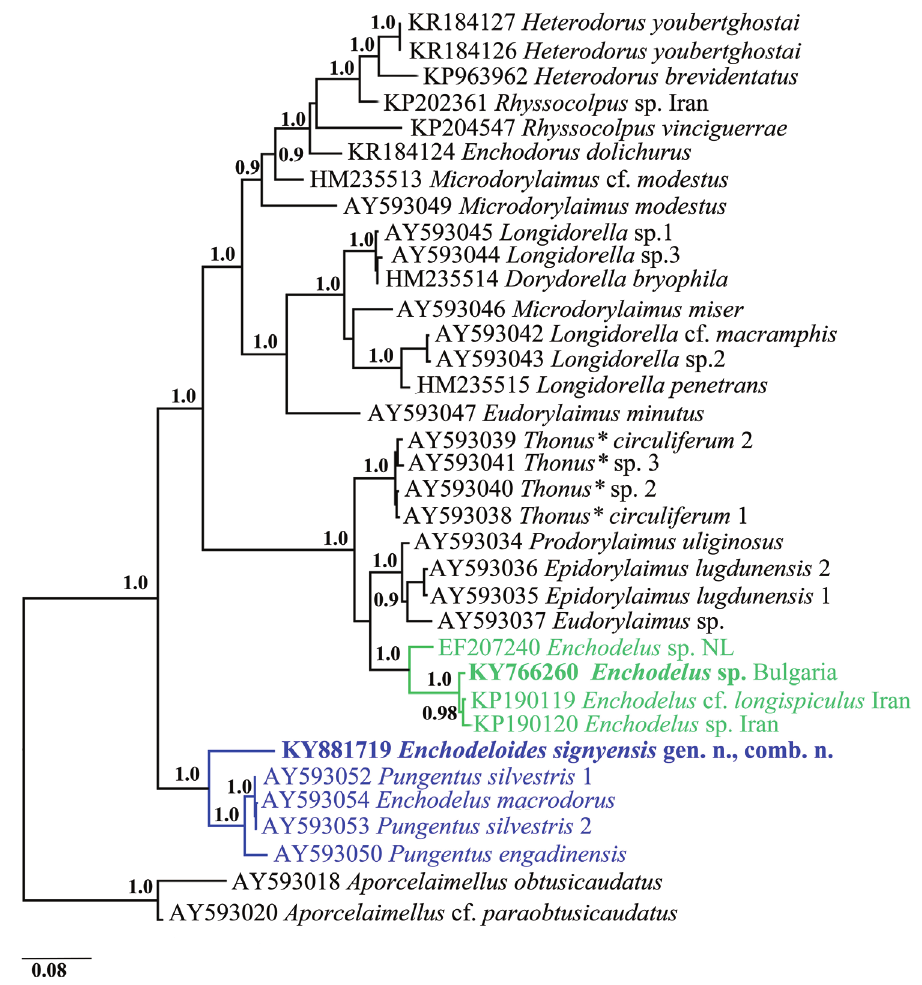
Figure 9. Phylogenetic relationships of Enchodeloides signyensis (Loof, 1975), gen. n., comb. n. (= En- chodelus signyensis Loof, 1975) based on 28S rDNA D2-D3 inferred from a Bayesian analysis (GTR+G model) and two Aporcelaimellus species used as an outgroup. * Thonus is currently considered a synonym of Crassolabium (Peña-Santiago & Ciobanu,